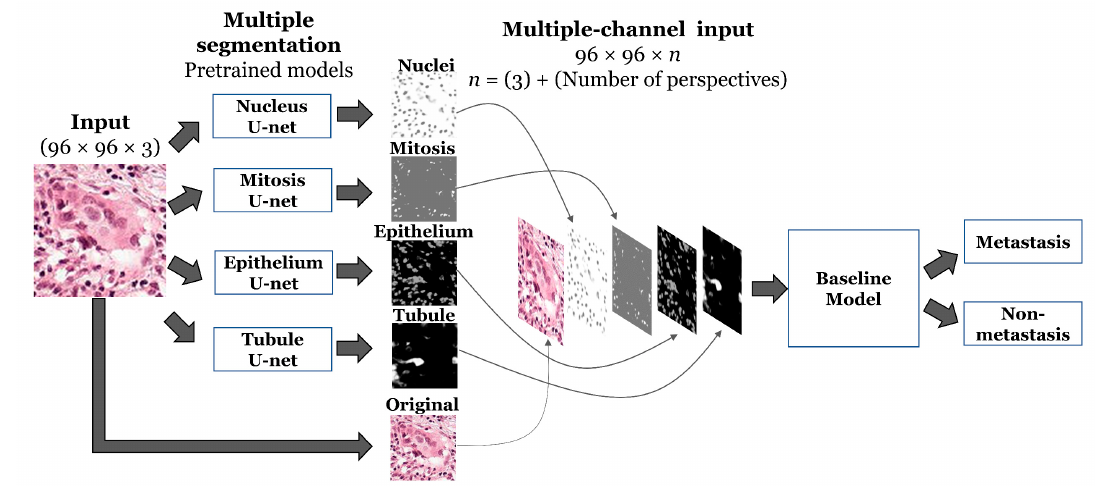
Figure 1. Visual representation of the proposed ConcatNet model. Table 1. Results on the training of U-net